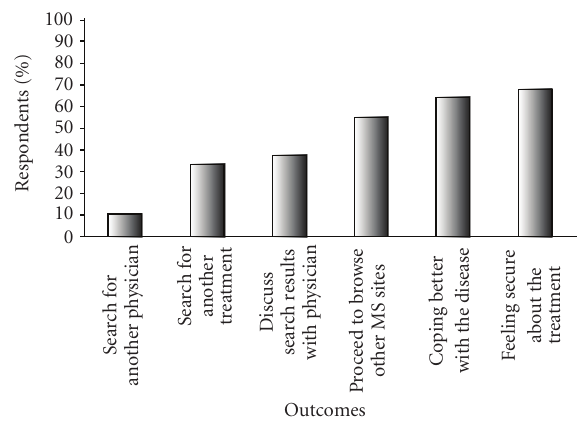
Figure 2: Outcomes of searches about MS (response rate: 77% to